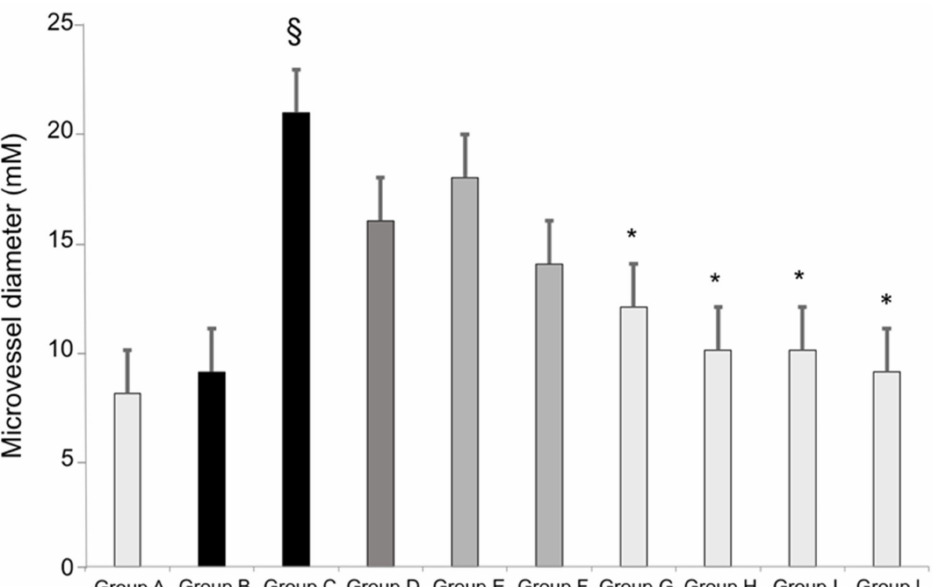
Figure 2. Gastric sub-epithelial micro-vessel diameter in healthy volunteers receiving placebo orally or sublingually (Groups A and B, respectively); receiving 100 or 50 mg of standard aspirin orally (Groups C and D, respectively); receiving 100 or 50 mg of standard aspirin sublingually (Groups E and F, respectively); receiving aspirin micronized and cogrinded with collagen orally (Groups G and H) or sublingually (Groups I and L). § p < 0.05 standard aspirin vs. placebo; * p < 0.05 collagen cogrinded aspirin vs. standard